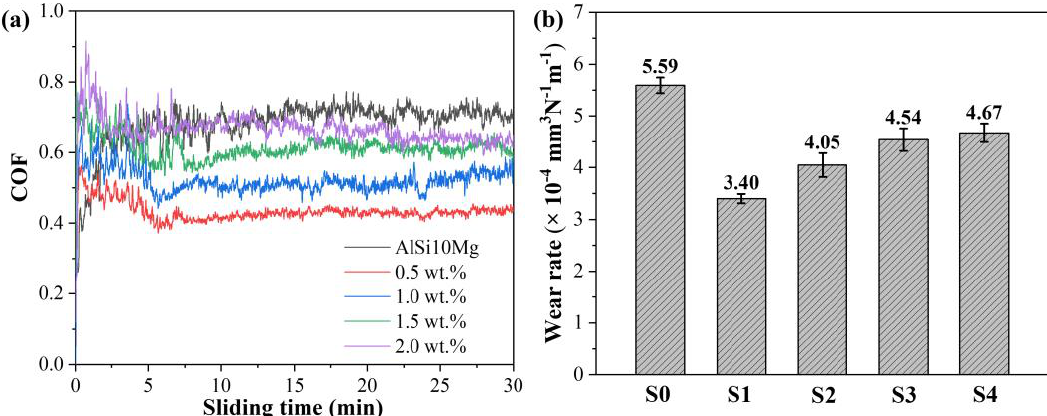
Figure 14. Wear properties of the SLMed part: Coefficient of friction ( a ) and the wear rate ( b ).